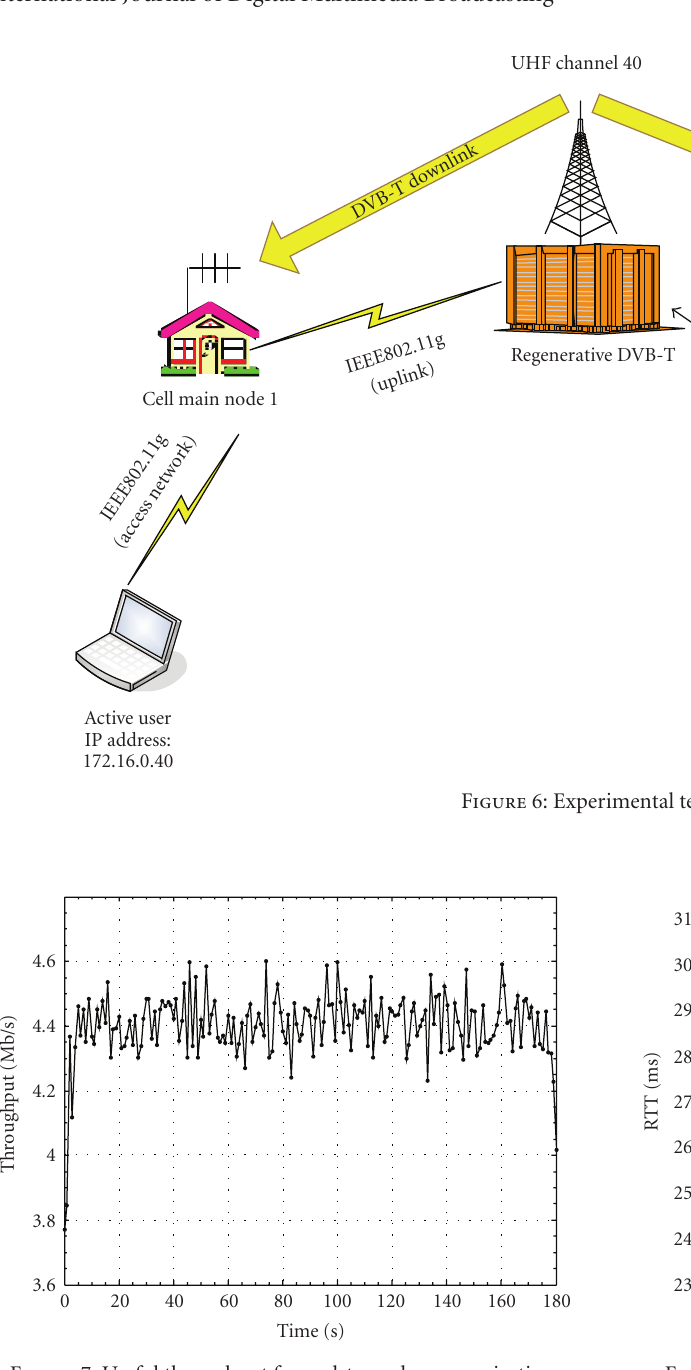
Figure 7: Useful throughput for end-to-end communication. Figure 8: Round trip time for end-to-end